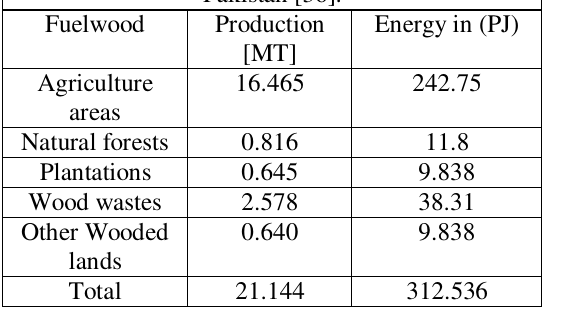
Table 4: Fuelwood production from forests in Pakistan [36].